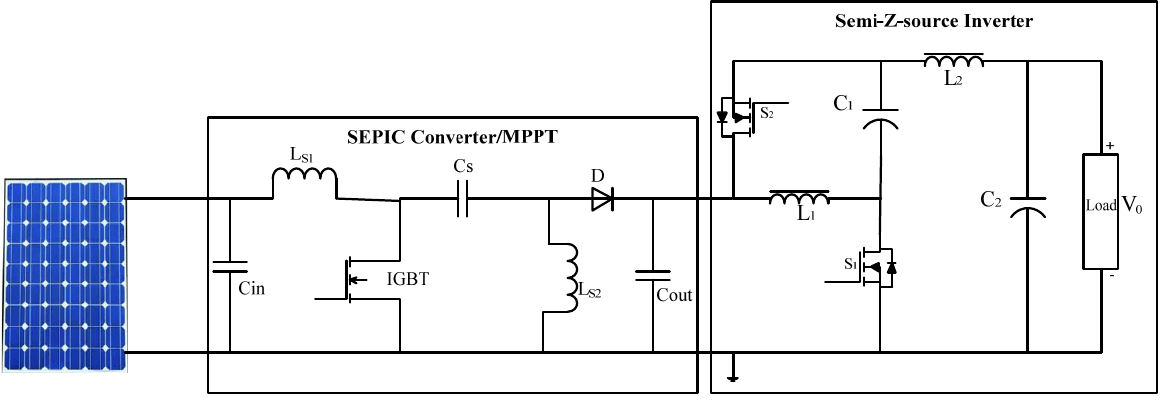
Figure 1. Proposed single phase semi-Z-source inverter with